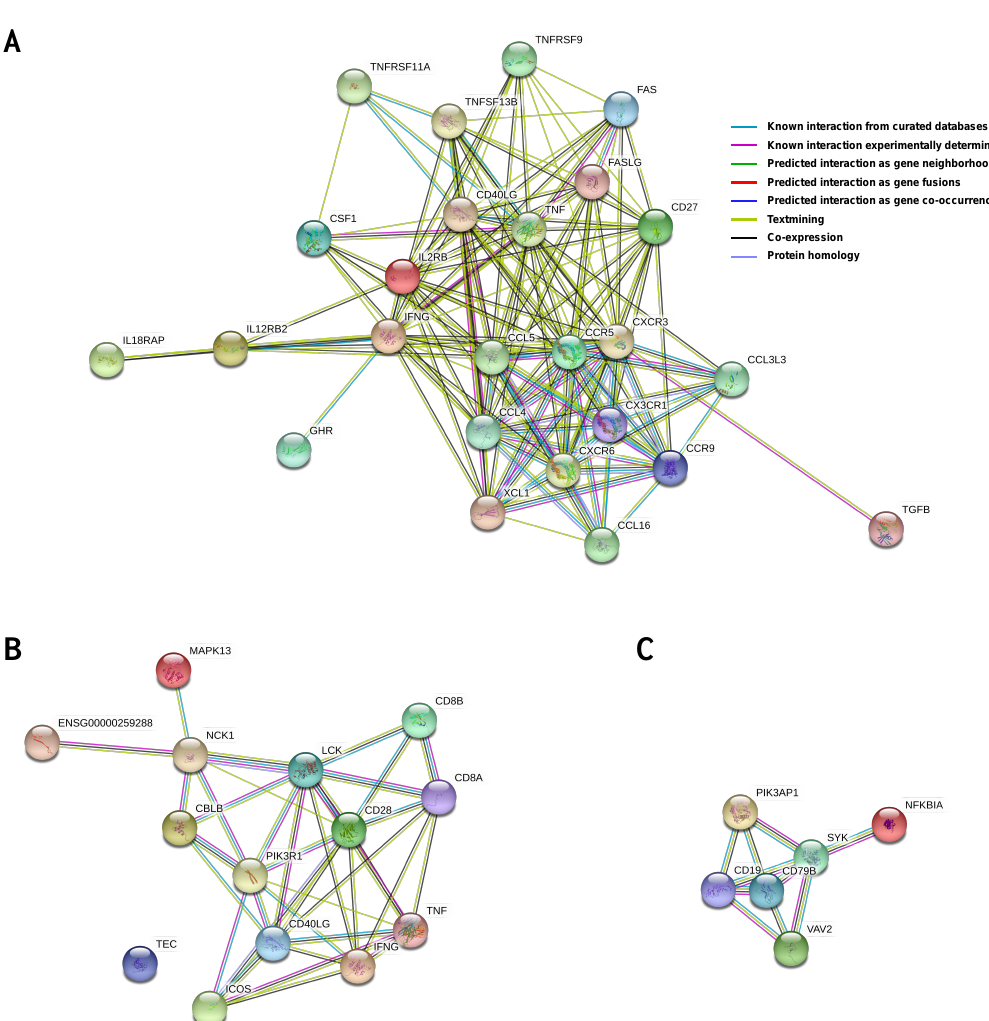
Figure 4. PPIs were drawn using significant genes in each main pathway: ( A ) cytokine-cytokine receptor interaction; ( B ) T cell receptor signaling pathway; ( C ) B cell receptor signaling